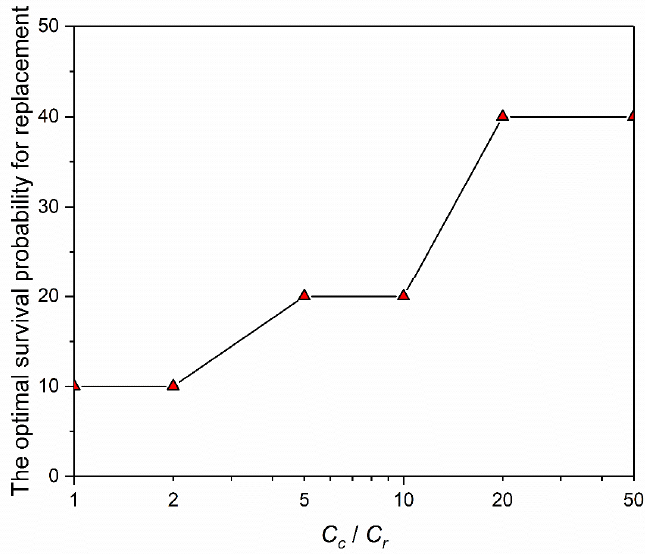
Figure 12. Influences of (cid:1829) (cid:3030) /(cid:1829) (cid:3045) on the optimal survival probability for replacement for the example water